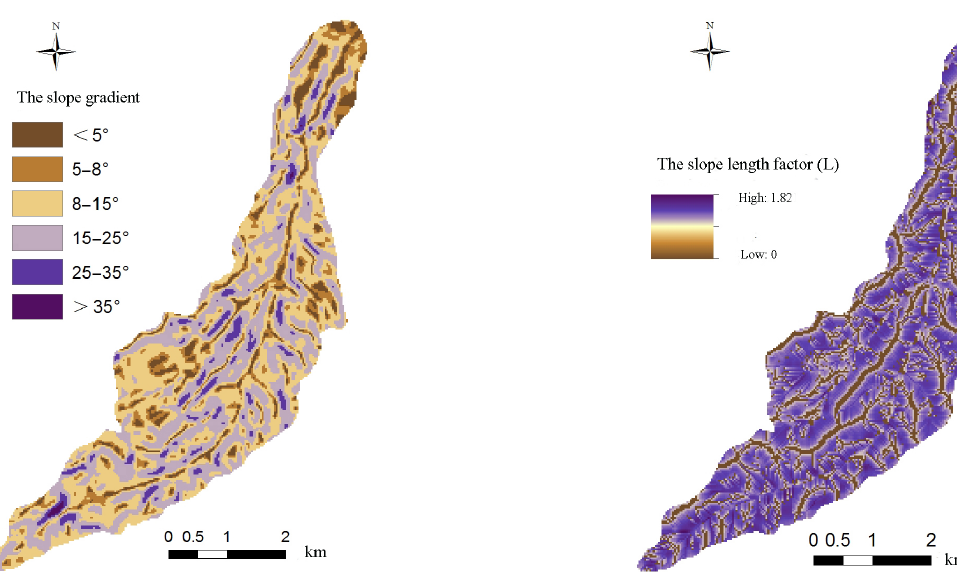
Figure 7. Spatial distribution of slope steepness.